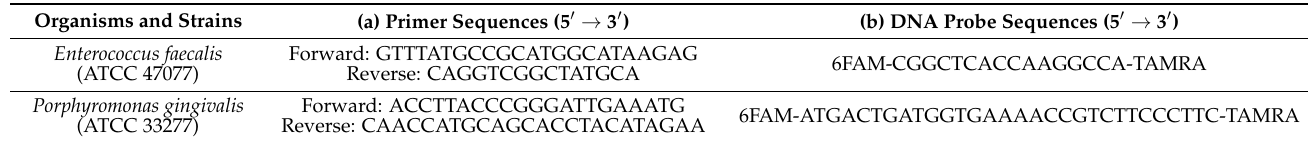
Table 1. (a) Species-specific primer sequences used in this study; and (b) Species-specific DNA probe sequences used in this